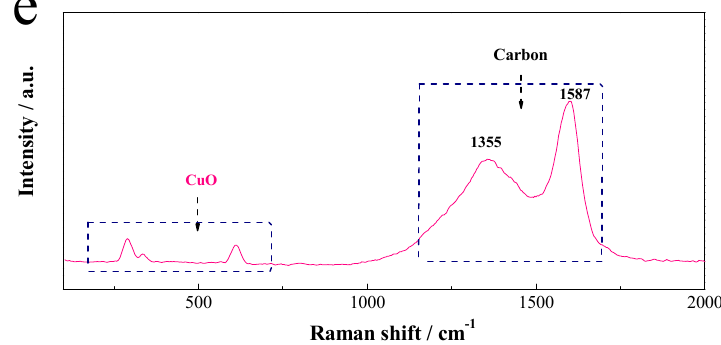
Figure 2. ( a – c ) Transmission electron microscopy (TEM) images of CuO/C core/shell nanowires (HRTEM image in inset); ( d ) X-ray power diffraction (XRD) pattern of CuO/C core/shell nanowires; ( e ) Raman spectrum of CuO/C core/shell nanowires.